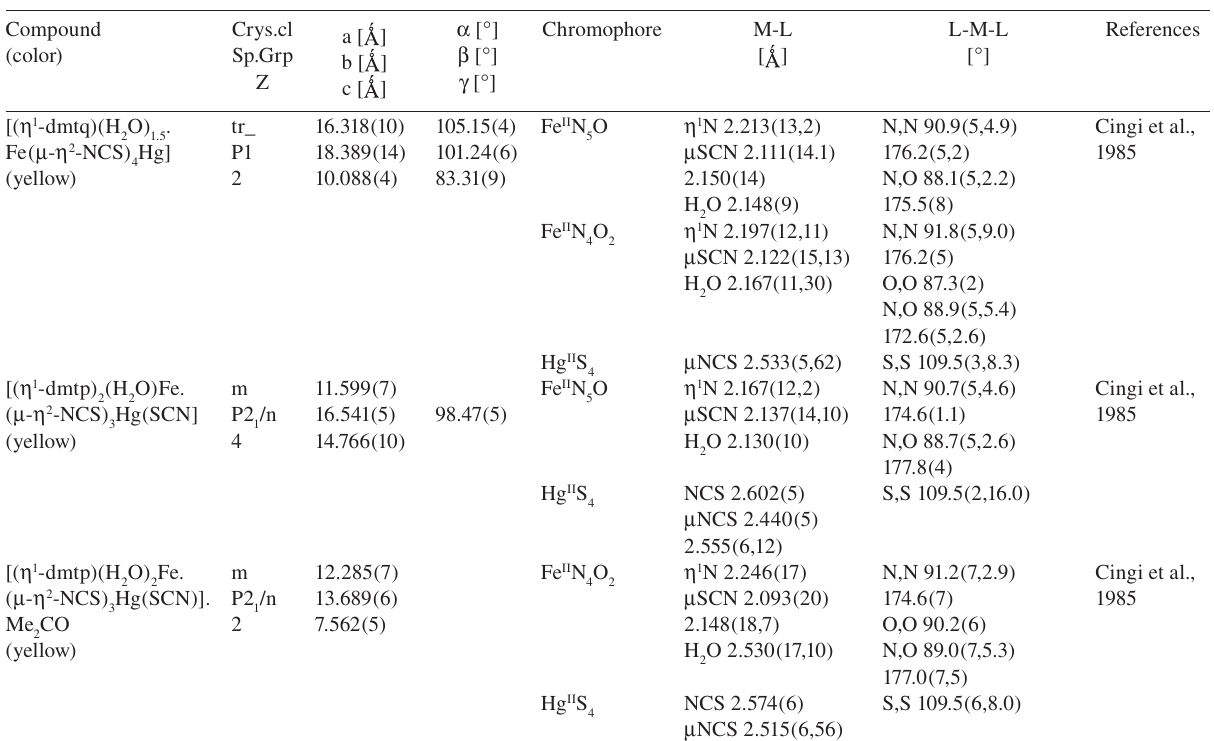
Fe( μ -CN) Mg(H O) (1-Meim) (Johnson et al. , 1991 ). 3 2 2 2